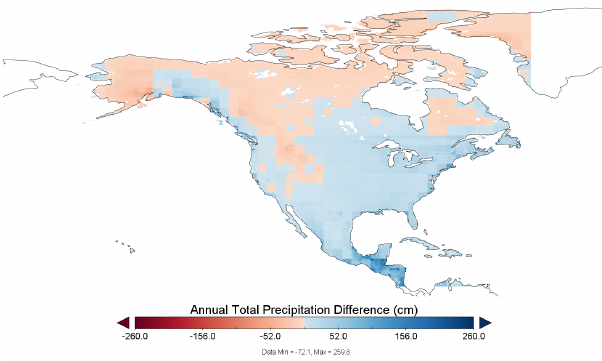
Figure 2. Difference map between the long-term mean (1979– 2010) annual total precipitation from rescaled NARR and original NARR (rescaled NARR precipitation – original NARR precipita- tion).